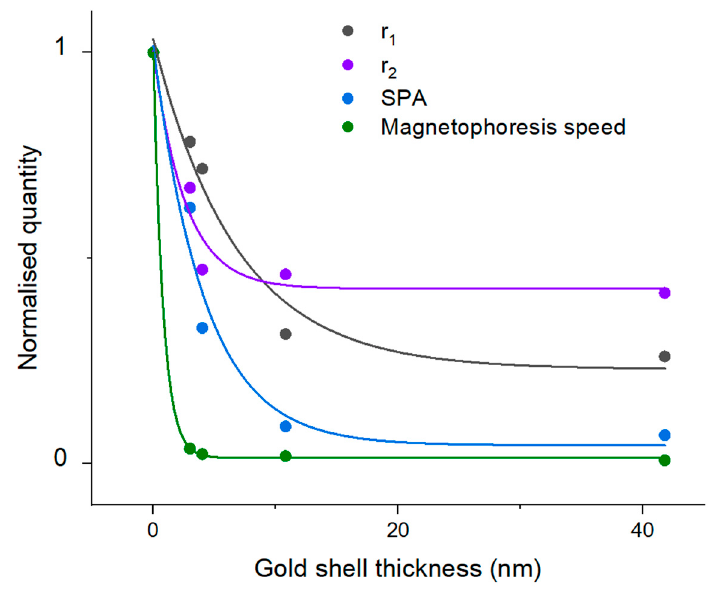
Figure 5. Exponential dependency of the normalized NMR relaxivities r 1 and r 2 , the specific power absorption (SPA), and the magnetophoresis speed (v mag ) as a function of gold shell thickness. See Table 1 for values.